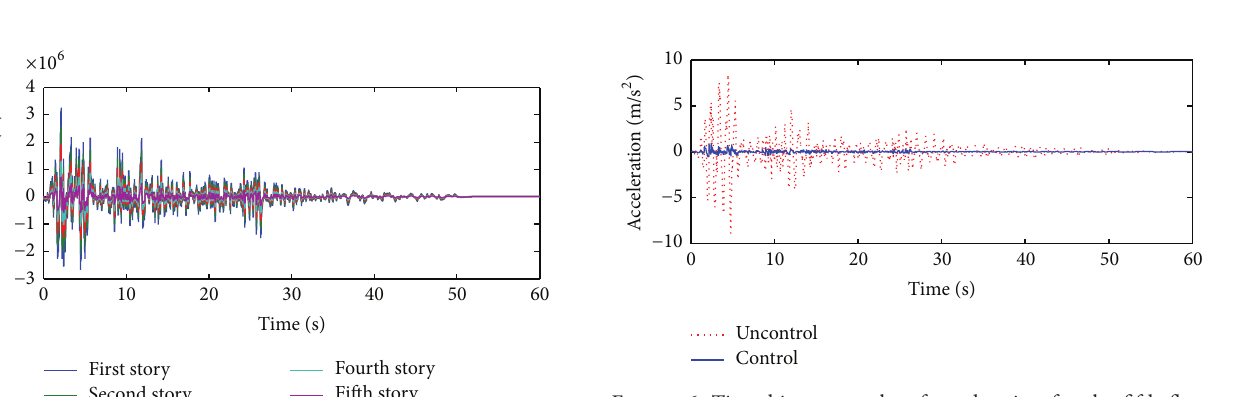
Figure 6: Time history graphs of acceleration for the fifth floor for uncontrolled and synchronized control coupled with 𝐻 2 / LQG algorithm in El Centro Earthquake (1940).